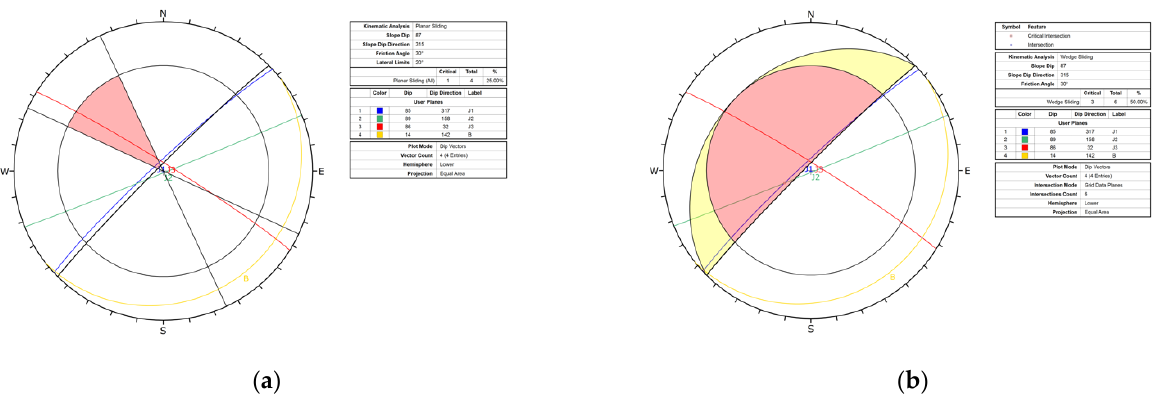
Figure 12. Kinematic analysis for: ( a ) planar sliding and ( b ) wedge sliding failure in sub-region U3.